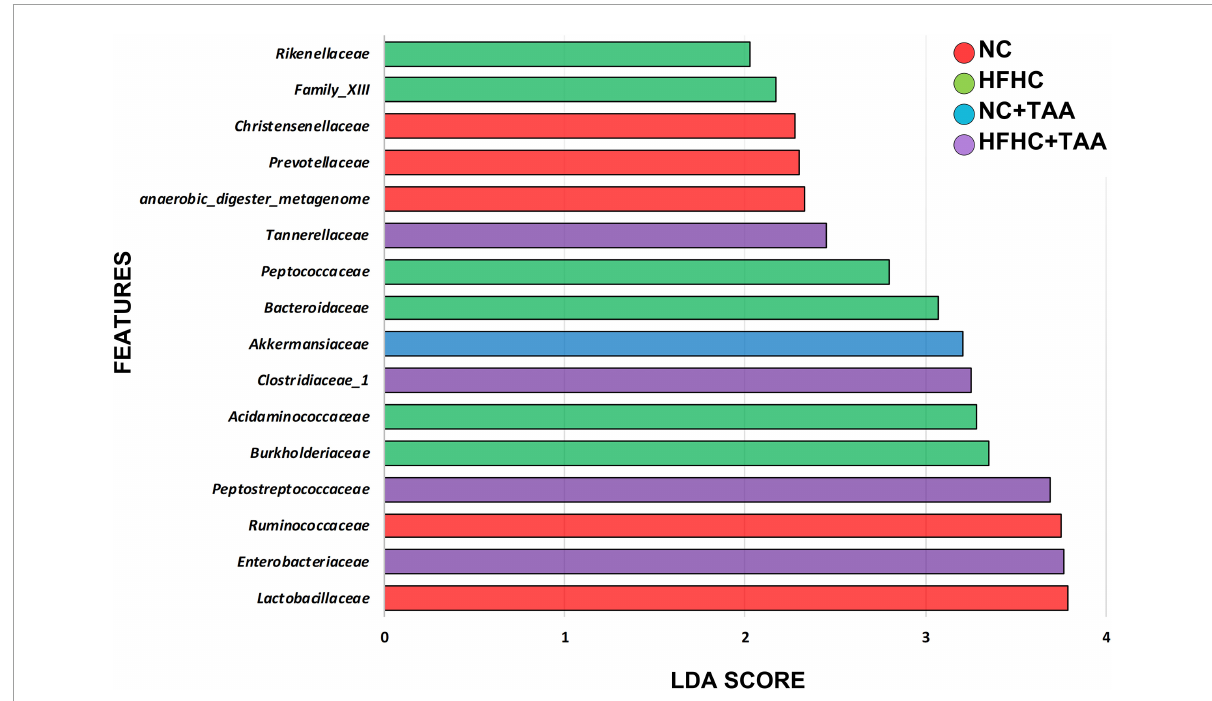
FIGURE7 Gut microbiota differences. Results of LEfSe analysis (LDA scores > 2 and significance of p < 0.05 as determined by Wilcoxon’s signed-rank test) show taxa are significantly different among experimental groups. Red indicates discriminant families in the NC group; green indicates discriminant families in the HFHC group; blue indicates discriminant families in the NC + TAA group; and purple indicates in the HFHC + TAA group.